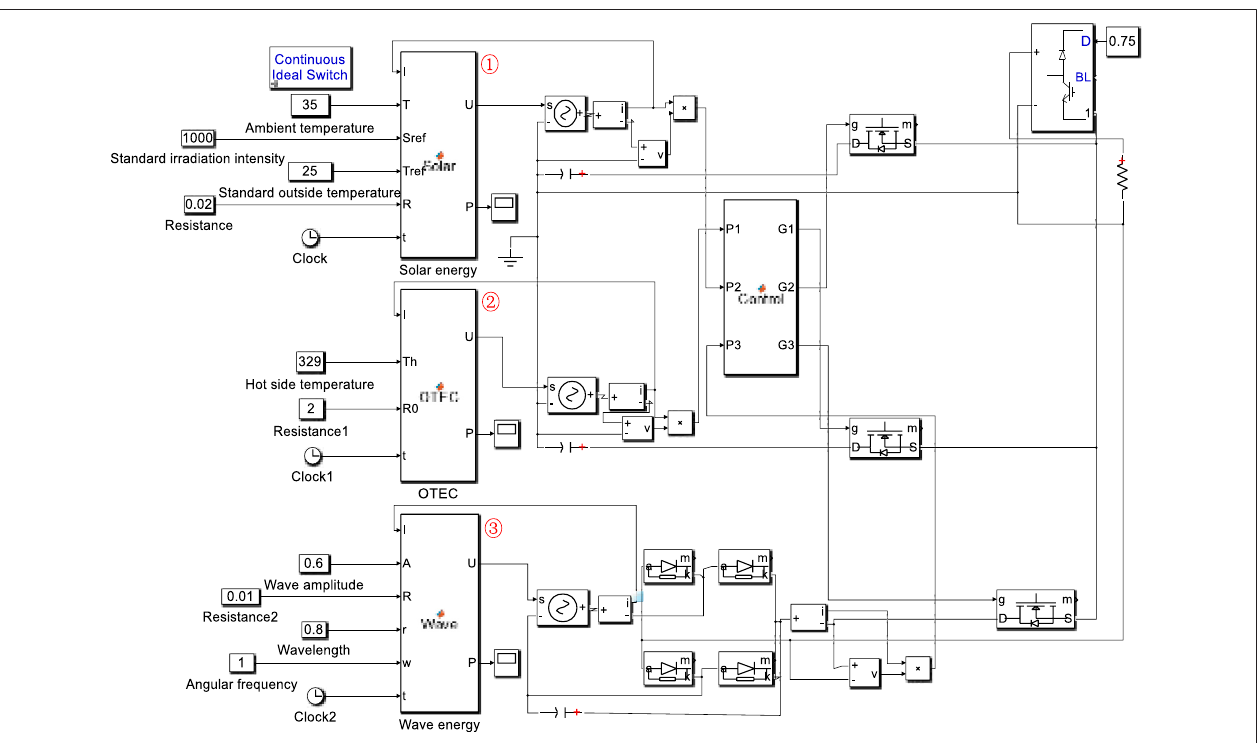
FIGURE 14 | Mixed environmental energy collection and the management system